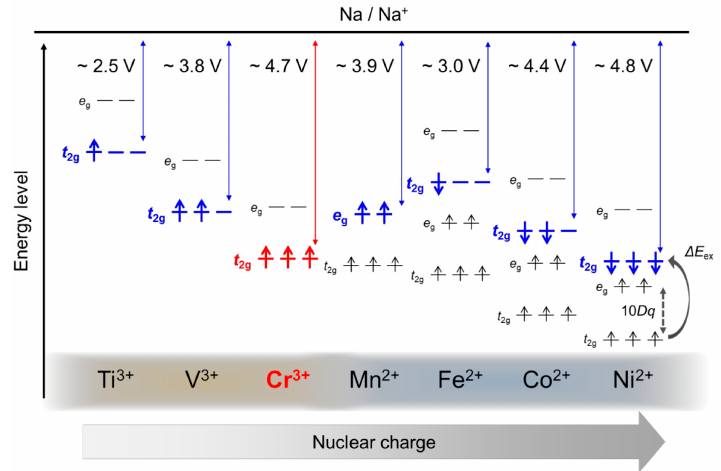
Figure 2. Schematic comparison of operating voltages and d-electron configurations for phosphate- based cathode materials containing 3d transition metals [19]. 10 Dq and Δ E ex indicate an octahedral crystal field splitting energy for 3d orbitals and exchange splitting energy, respectively. Orange and blue shading corresponds to valences of 3 and 2, respectively. Note that there is also a contribution of the Madelung and other energies to the cell voltage that is superimposed on the electronic con- tribution of the transition metal ions (see Figure 1). Permission is granted by Chemistry of Materials.